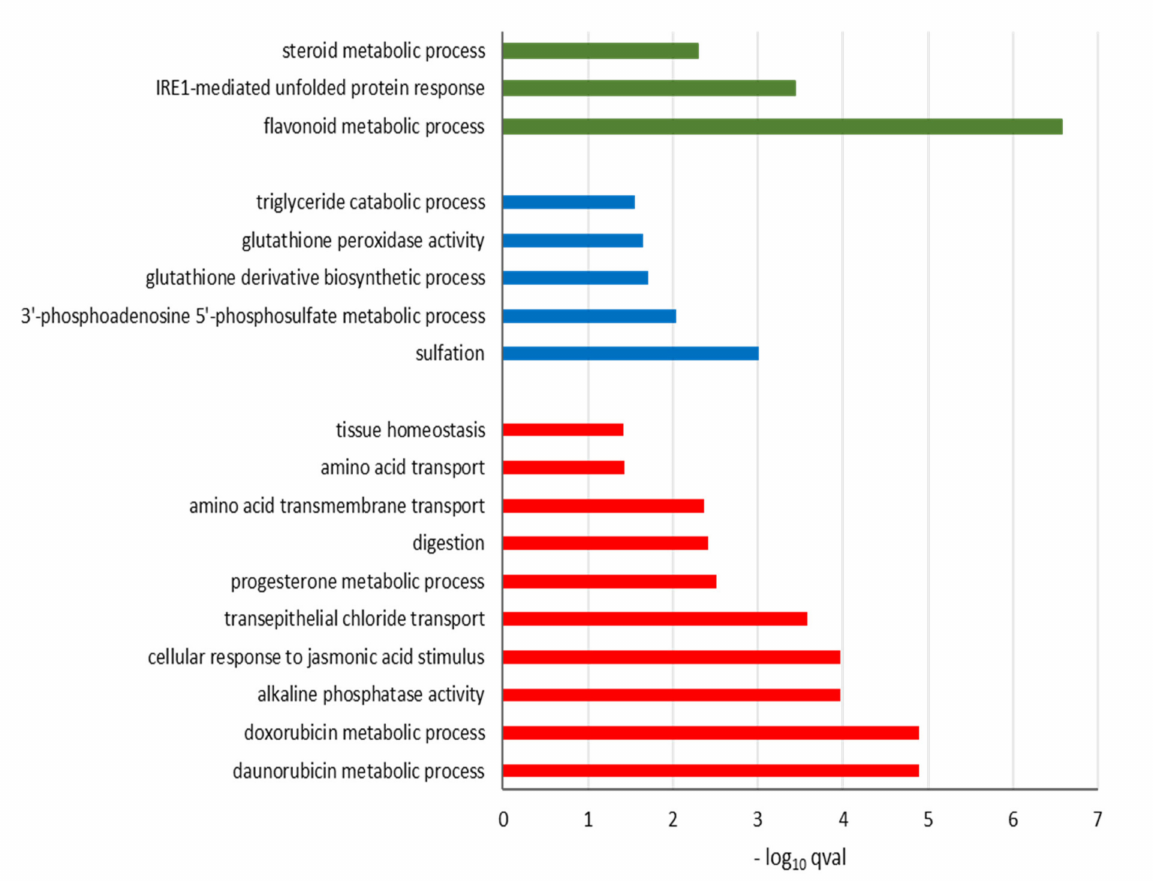
Figure 5. Gene Ontology (GO) enrichment analysis of di ff erentially expressed genes of oligosaccharides treated compared to mock treated Caco–2 cells. Di ff erentially expressed genes (FDR p –adj. < 0.05, | FC | ≥ 1.5) were clustered according to GO bioprocesses classification. (cid:4) GOS up-regulated; (cid:4) GOS down-regulated; (cid:4) FOS